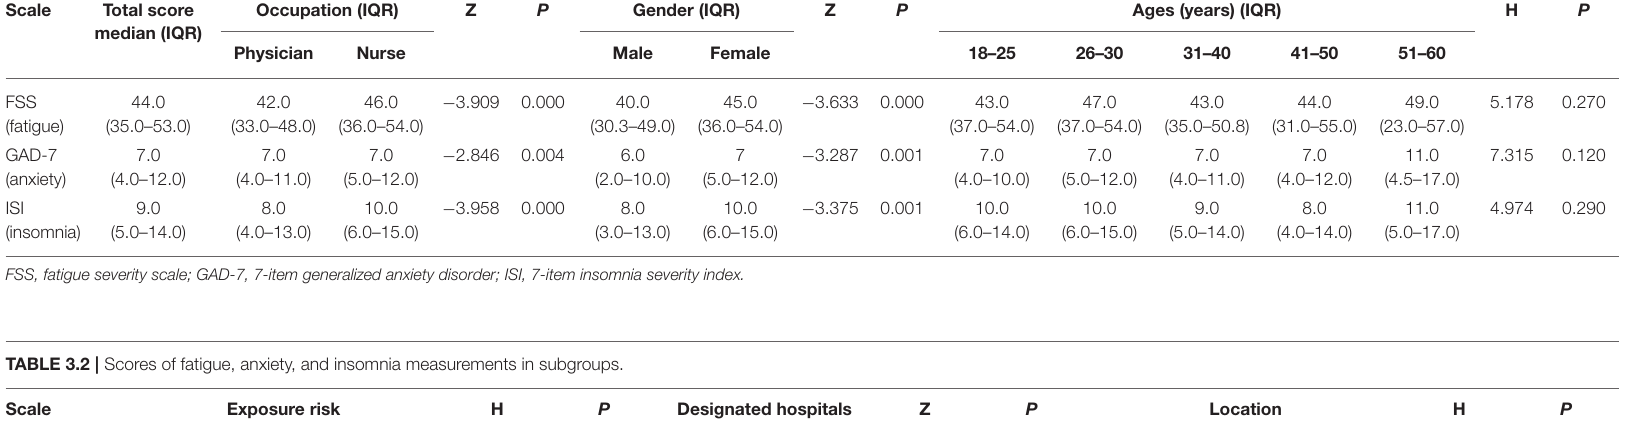
TABLE 3.1 | Scores of fatigue, anxiety, and insomnia measurements in total cohort and subgroups. Scale